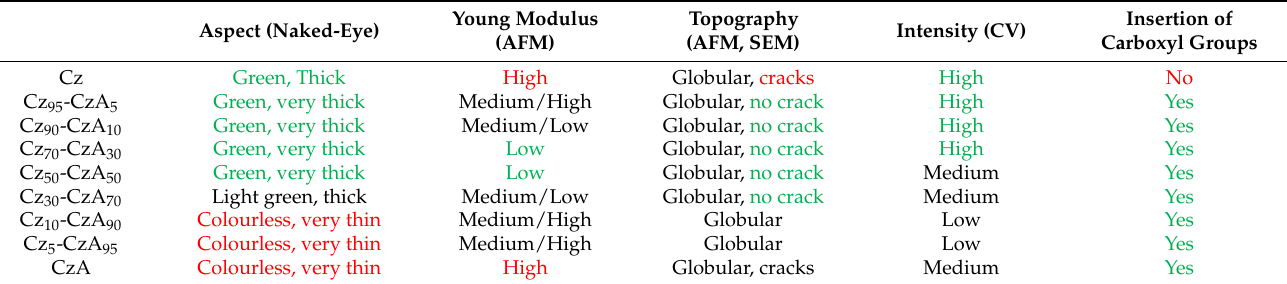
Table 2. Comparison of the physico-chemical properties of the films obtained by oxidation of Cz, CzA and Cz:CzA mixtures (in green: beneficial properties, in red: adverse properties, in black: neutral